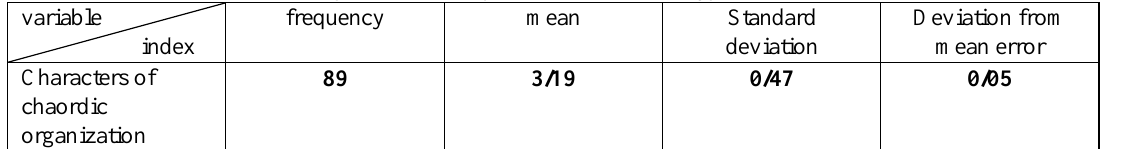
The descriptive statistics parameters of main